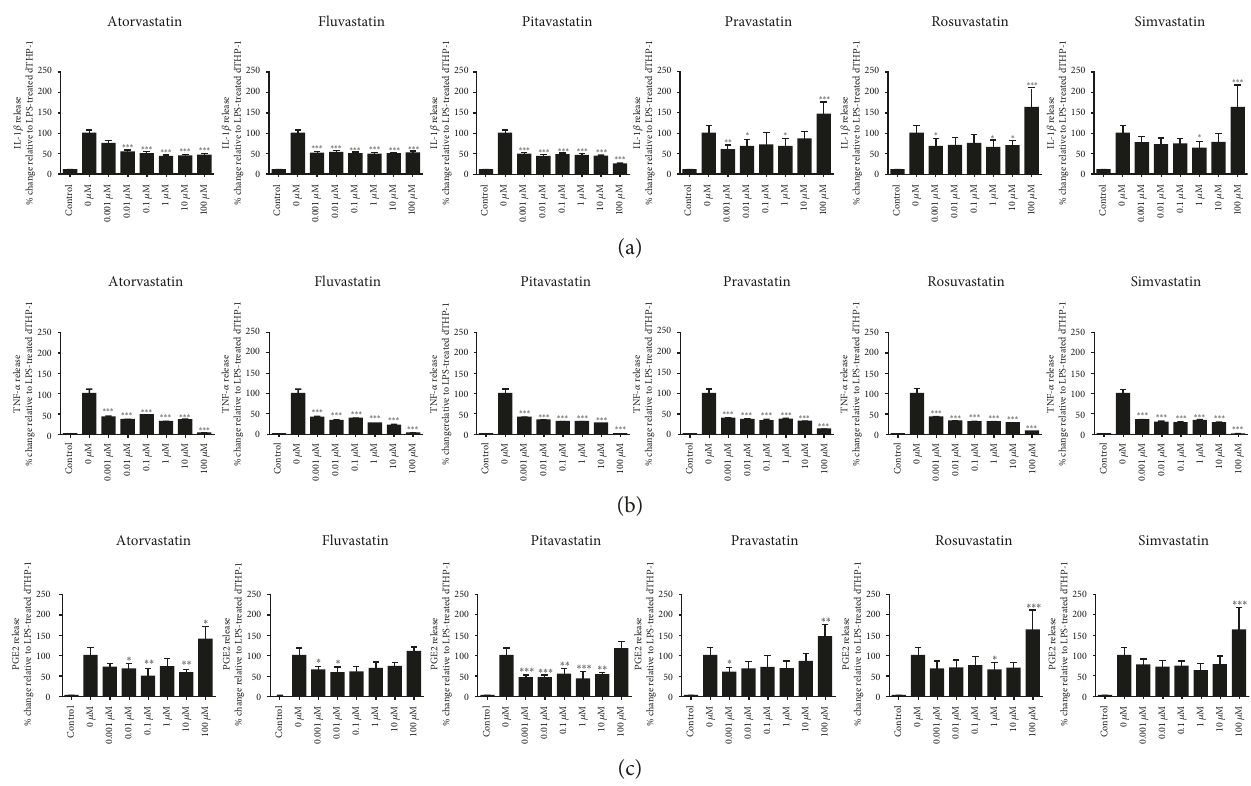
Figure 2: Statin-induced changes in (a) IL-1 β , (b) TNF- α , and (c) PGE2 release in LPS-activated dTHP-1 cells. Cells were pretreated for 24h with one of the six statins (0 – 100 μ M) prior to receiving a 24 h LPS stimuli, after which time IL-1 β , TNF- α , and PGE2 release were quanti fi ed by ELISA. Control cells represent cells treated with statin and LPS vehicles. Data shown is mean +SD of four independent experiments; vehicle control (0 μ M) is represented as mean +SEM. ∗ Statin treatment versus LPS